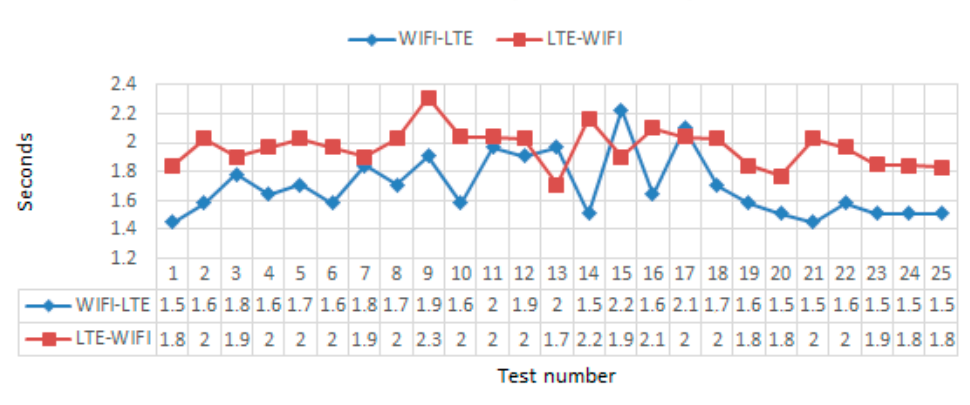
Figure 19. Time spent in the vertical handover (LTE ←→ WiFi).